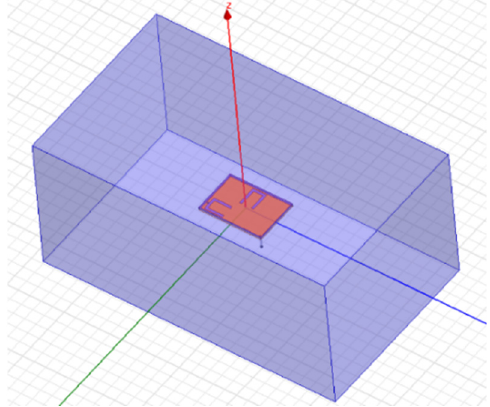
Figure 1. Proposed antenna design for pancreas implantation.